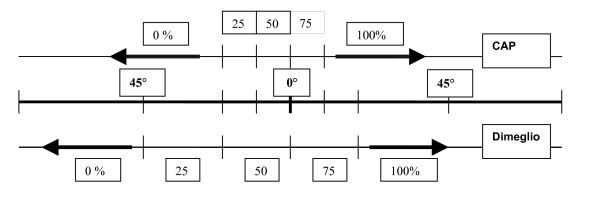
Proportion in scoring distribution between the Dimeglio scoring system and the CAP for the item "derotation/eversion".